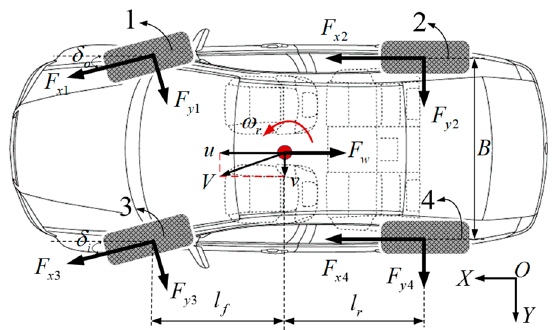
Figure 4. Seven degrees of freedom (7-DOF) vehicle dynamic mode.